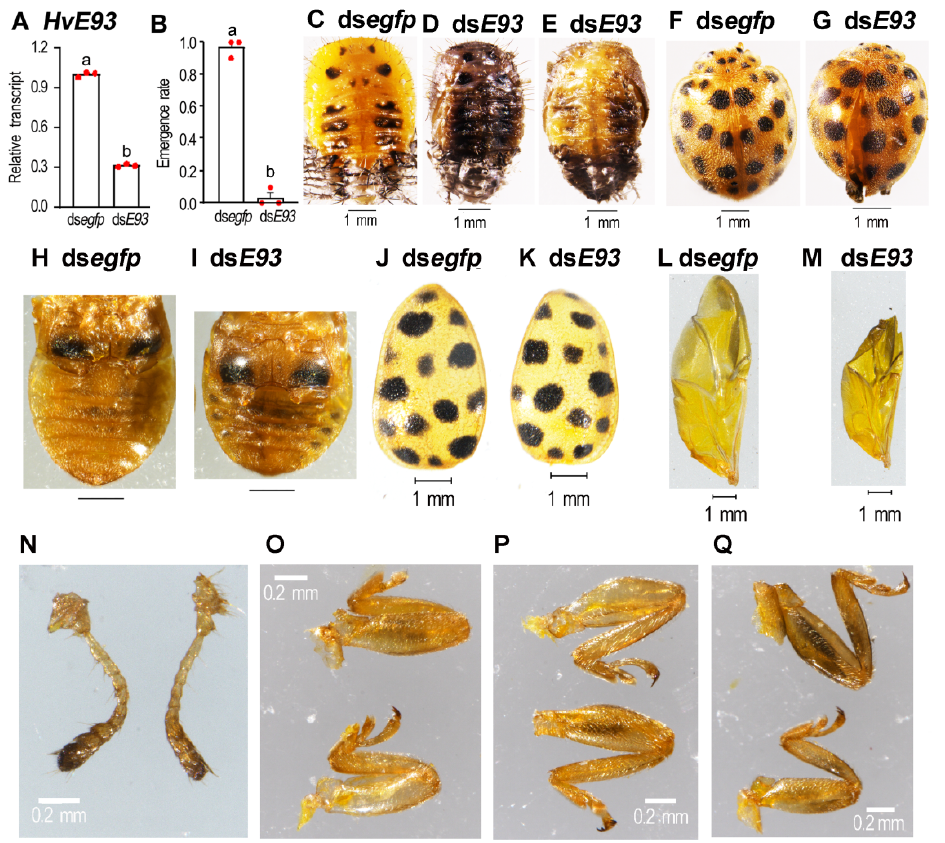
Figure 7. Depletion of both HvE93 isoforms in the pupae causes failure of adult emergence in Henosepilachna vigintioctopunctata . Around 500 ng of ds E93 or ds egfp (0.1 μ L) was injected into the newly formed pupae. Three days after injection, the expression level (2 −ΔΔ CT value) of HvE93 was measured ( A ). The emergence rate was recorded during a 3-week trial period ( B ). Statistical significances ( p value < 0.05, showing by different letters above the columns) between treatment and control (means ± SE) were calculated using an independent sample t -test. Most treated pupae became darkened and dried ( D , E ), compared to normal pupae ( C ). A small portion of treated pupae emerge as adults ( B ), with deformed wings ( G vs. F ). The sizes of the abdomen ( I vs. H ), the elytrum ( K vs. J ), the hindwing ( M vs. L ), the antennae ( N , left vs. right ), the foreleg ( O , below vs. above ), the midleg ( P , below vs. above ) and the hindleg ( Q , below vs. above ) of the treated adults were compared with the corresponding organs from controls.